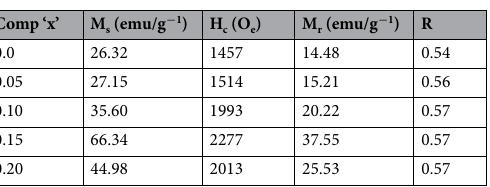
Comp ‘x’ M s (emu/g − 1 ) H c (O e )